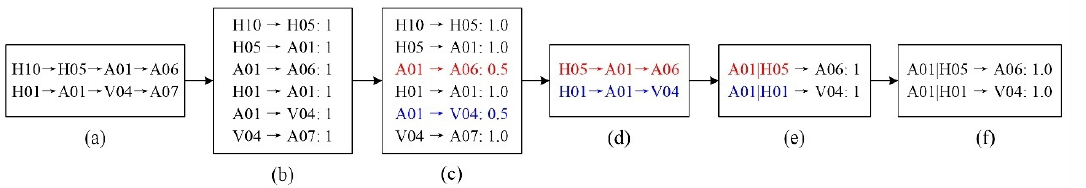
Figure 1. Path dependency extraction of HMTA chains. ( a ) Two accident chains. ( b ) The frequency of all subpaths. ( c ) The transfer probability from node i to node j . ( d ) The subpaths of A01 → A06 and A01 → V04 were extended to H05 → A01 → A06 and H05 → A01 → V04. ( e ) The frequencies of second-order subpaths. ( f ) The transfer probability of second-order path dependency. In HMTAs chains, a first-order subpath represents the sequence of any two adjacent nodes, e.g., H10 → H05, H05 → A01, etc. Based on the statistical data of HMTAs, all